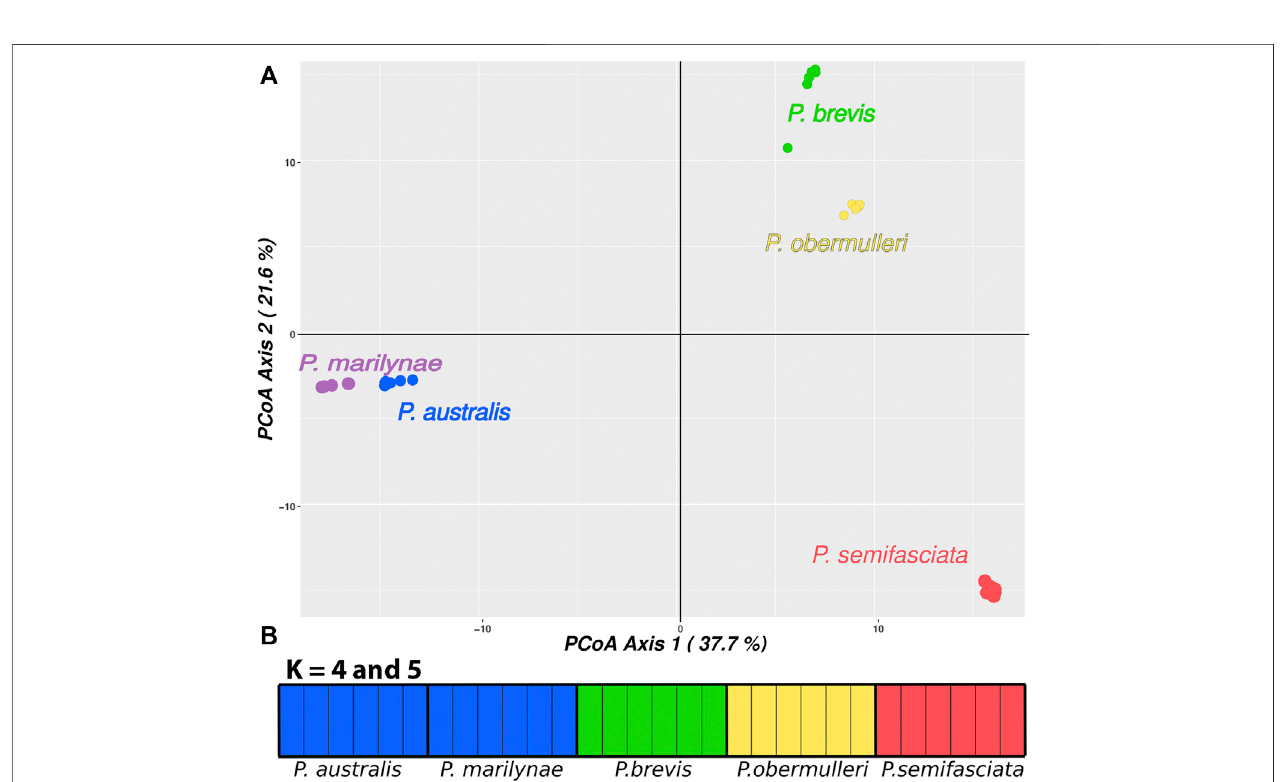
FIGURE3 |(A) Genetic diversity in Pyrrhulina species according to aPCoA. ThePCoA recovered 37.7% ofthetotal variation inthe fi rst principal coordinate (PC1), and 21.6% in the second principal coordinate (PC2). (B) — Results for fastStructure with K = 4 and K = 5. Each vertical bar represents an individual; the bar colors represent the group in which the fastStructure classi fi ed the individual; the legend below indicates their species.